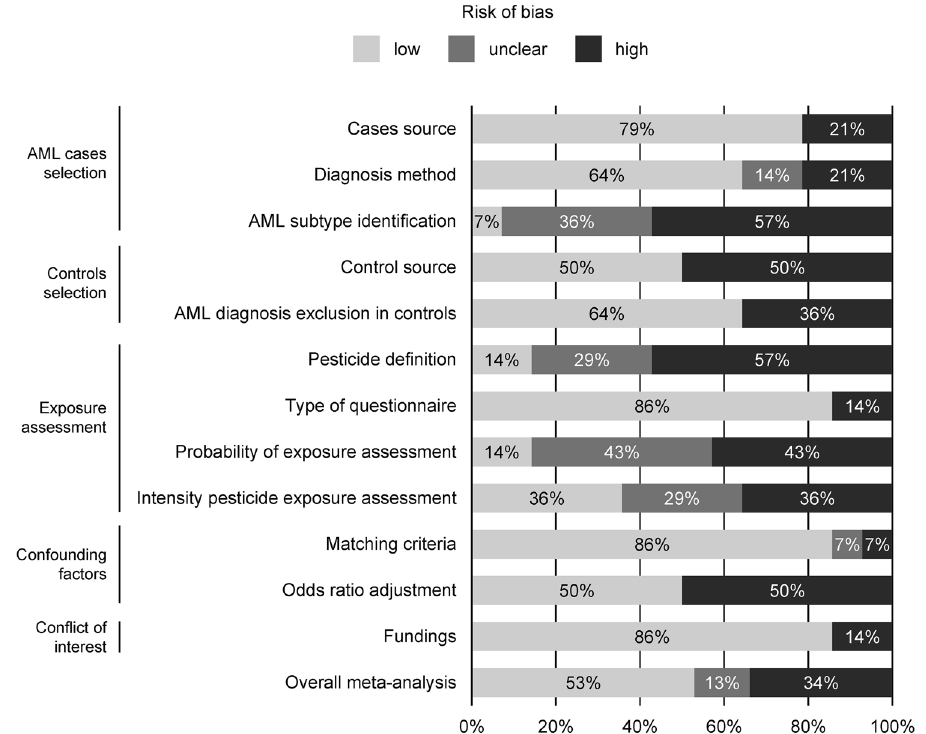
Figure 2. Risk of bias across studies assessed following Grading of Recommendations, Assessment, Development and Evaluation (GRADE) Working Group guidelines. Low, unclear and high, refer to plausible bias that are respectively unlikely, likely and seriously associated with weakening of the final results (defined in Table S1). Results in individual studies are reported in Fig